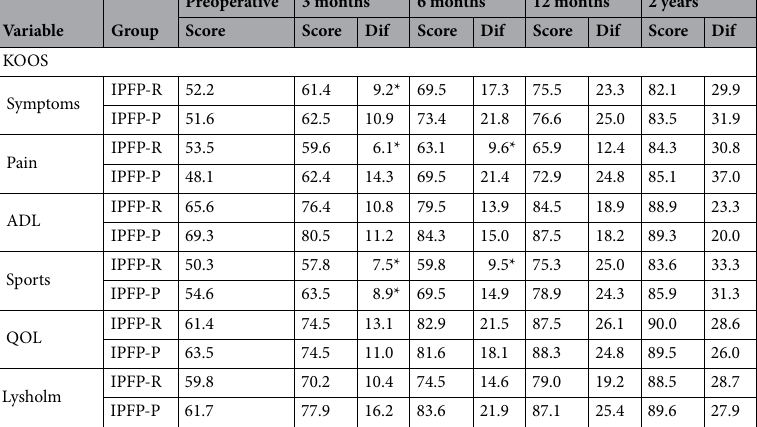
IPFP-R group and the remaining 4 patients were in the IPFP-P group. The four patients with deep infection were